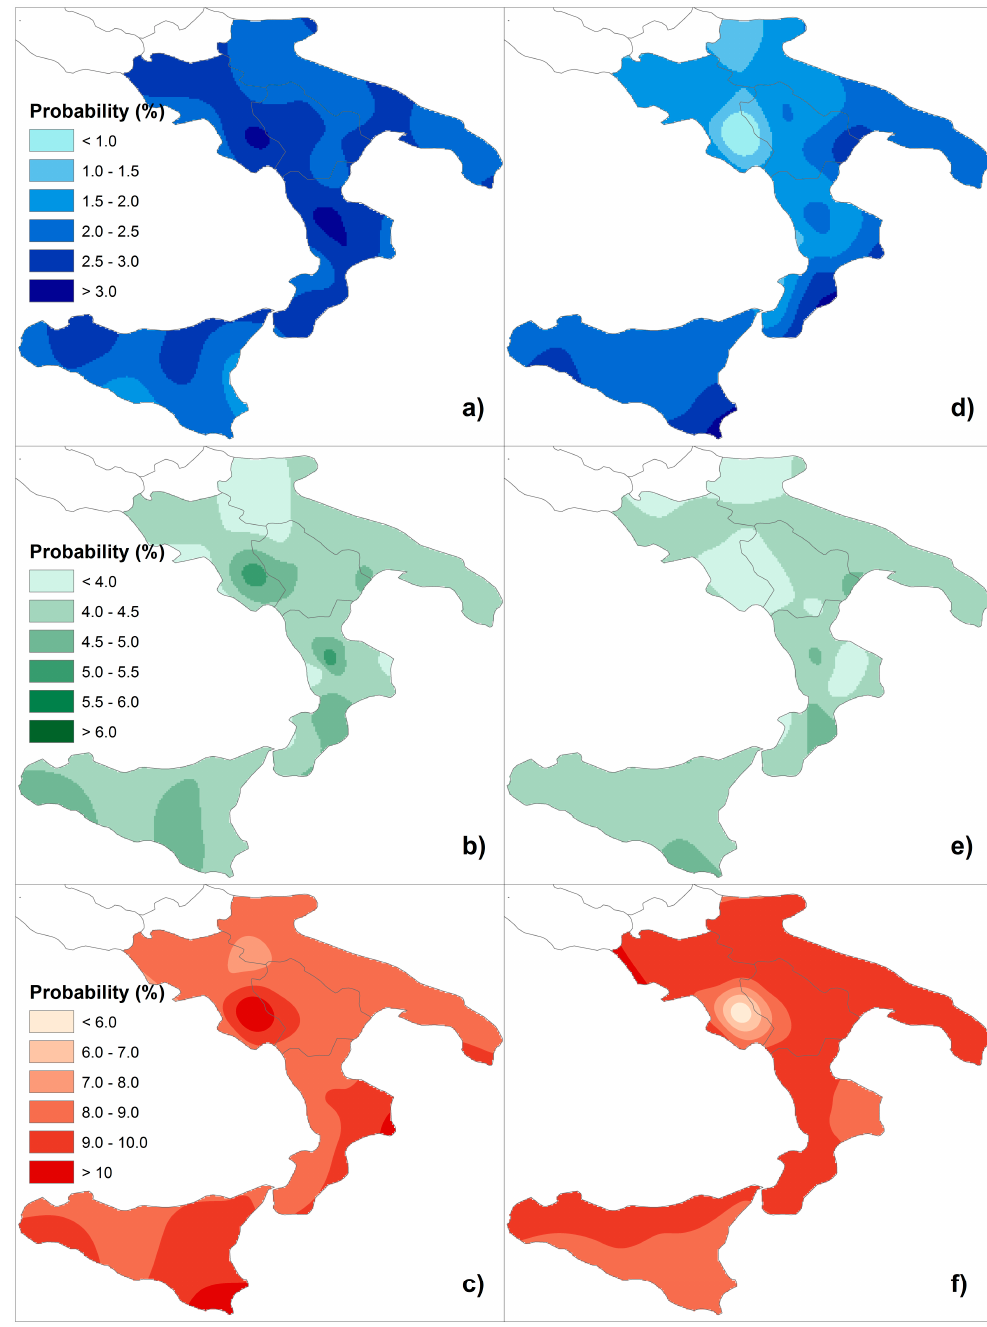
Figure 2. Maps of the monthly occurrence probabilities of Extreme drought ( a ), Severe drought ( b ), Moderate drought ( c ), Extremely wet ( d ), Severely wet ( e ) and Moderately wet ( f ) conditions for the 3-month SPI.